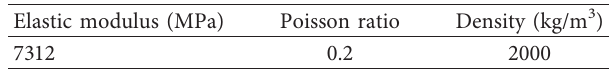
Table 9: The first 6 natural vibration periods.